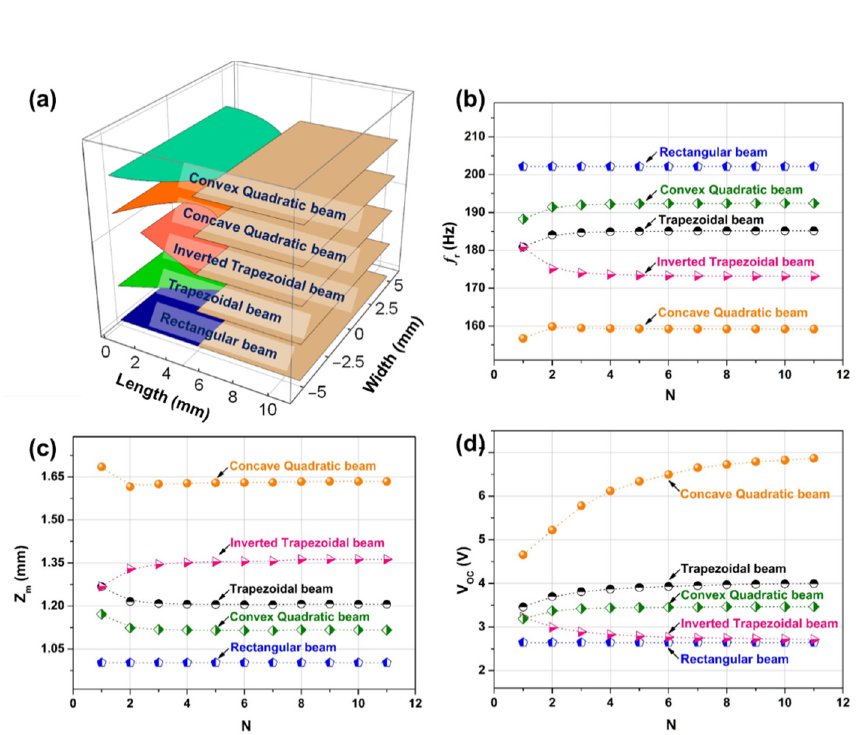
Figure 2. ( a ) The length and width dimension parameters of five MEMS variable cross-section cantilever beam based piezoelectric vibration energy harvesters with different cross-sectional shapes. The variations of the resonance frequency ( b ), the maximum displacement of the tip mass ( c ), and the open-circuit voltage ( d ) of the five devices with different cross-sectional shapes with the number of equal divisions N, when the external excitation acceleration is 1 g. Table 1. Output performance comparisons of the trapezoidal beam PVEH by using the ANSYS FEM and the constructed bidirectional coupled DP model.